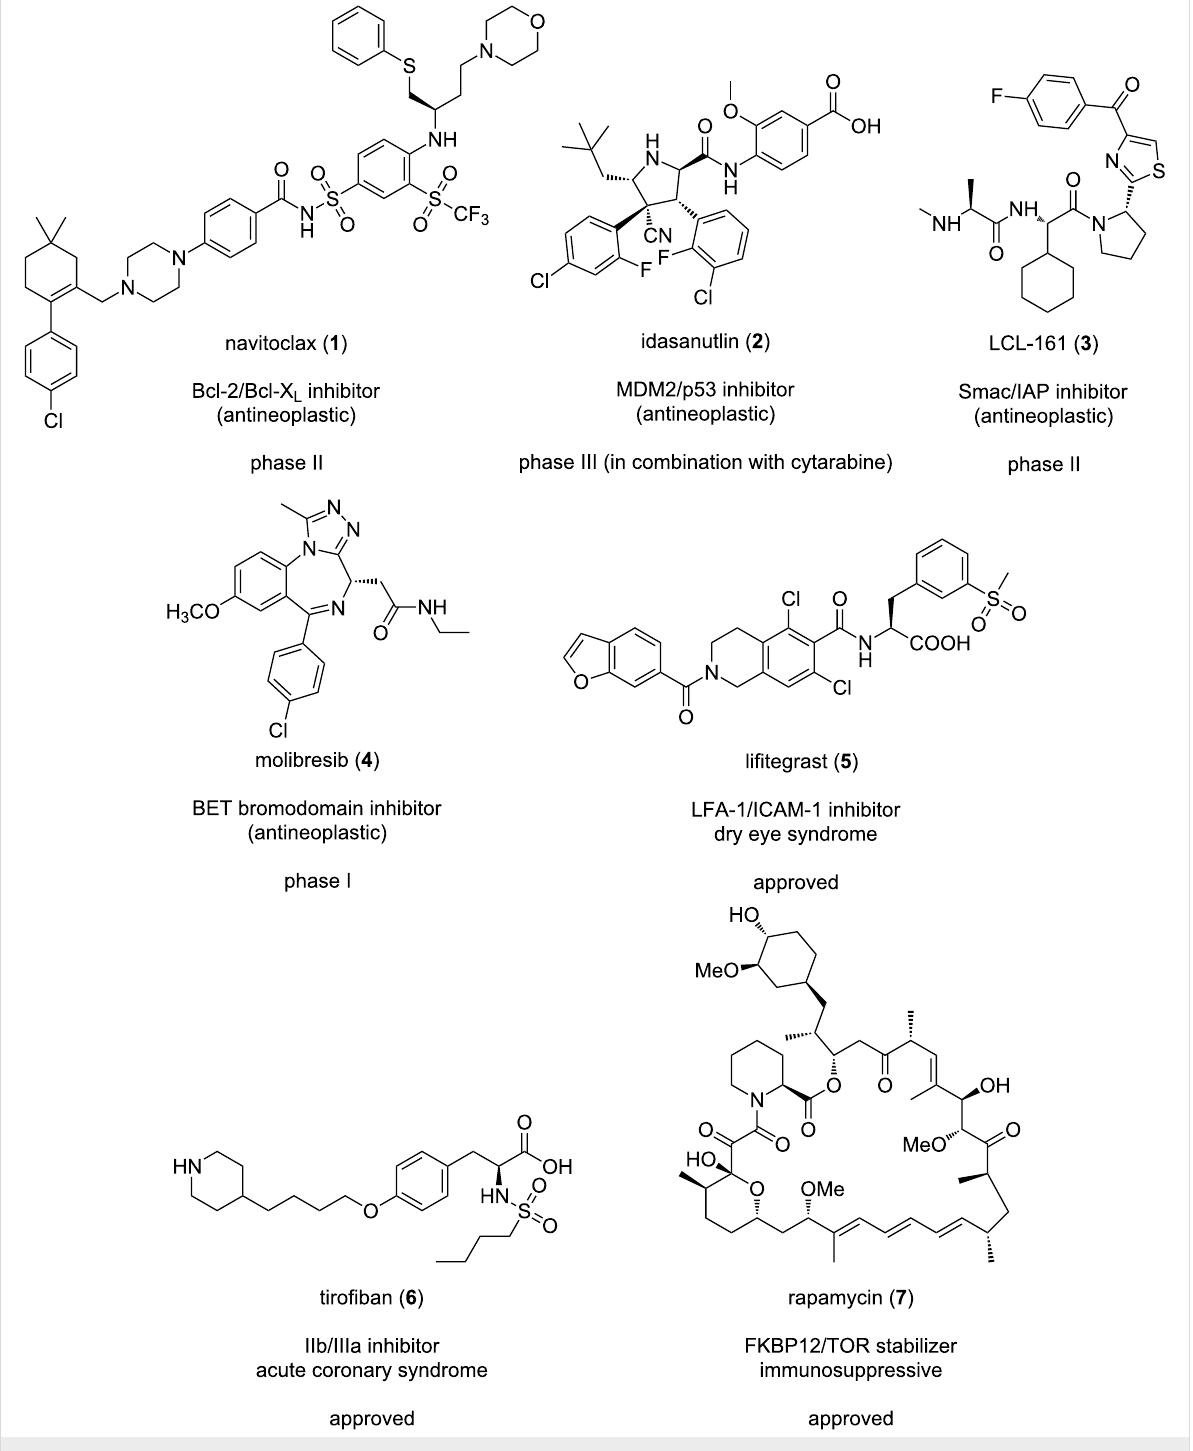
Mycoplasma pneumoniae [47]. Furthermore, partial PINs for Bacillus subtilis [48] and Streptococcus pneumoniae [49] have been reported recently, and many more are near completion